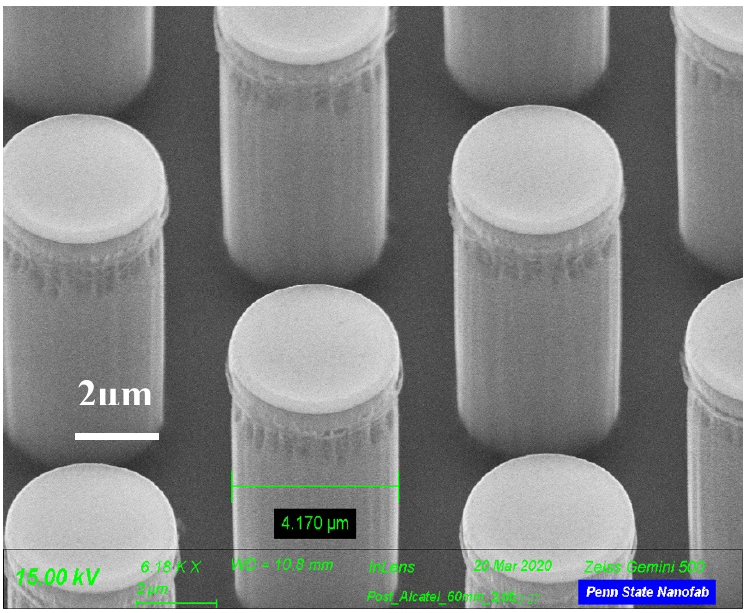
Figure 3. Micropillars with oxide layer. The diameter of the pillar is 4.17 μ m.